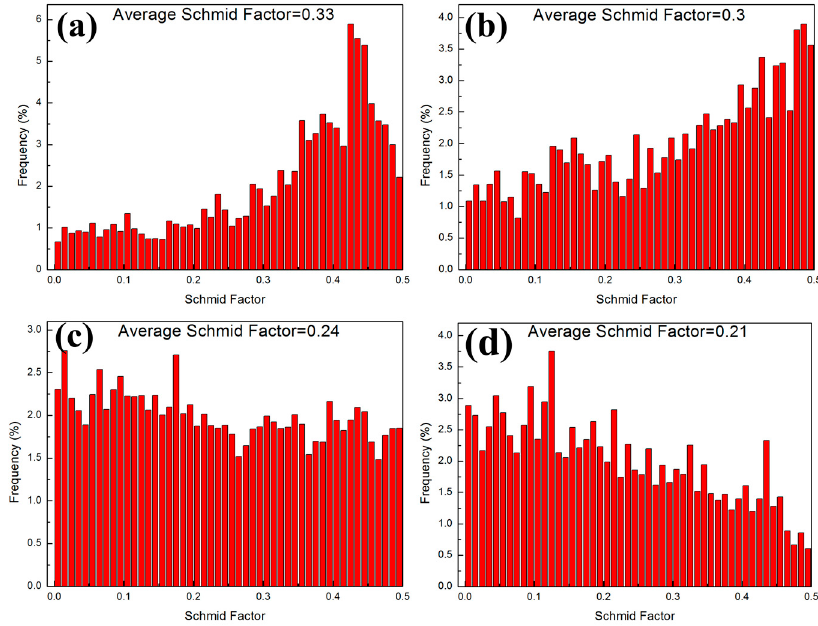
Figure 9. Schmid factor distribution of {0001} < 112(-)0 > basal slip along rolling direction (RD) in alloys HSRMFed with different pass strains ( a ) 0.1, ( b ) 0.16, ( c ) 0.22 and ( d ) 0.35.